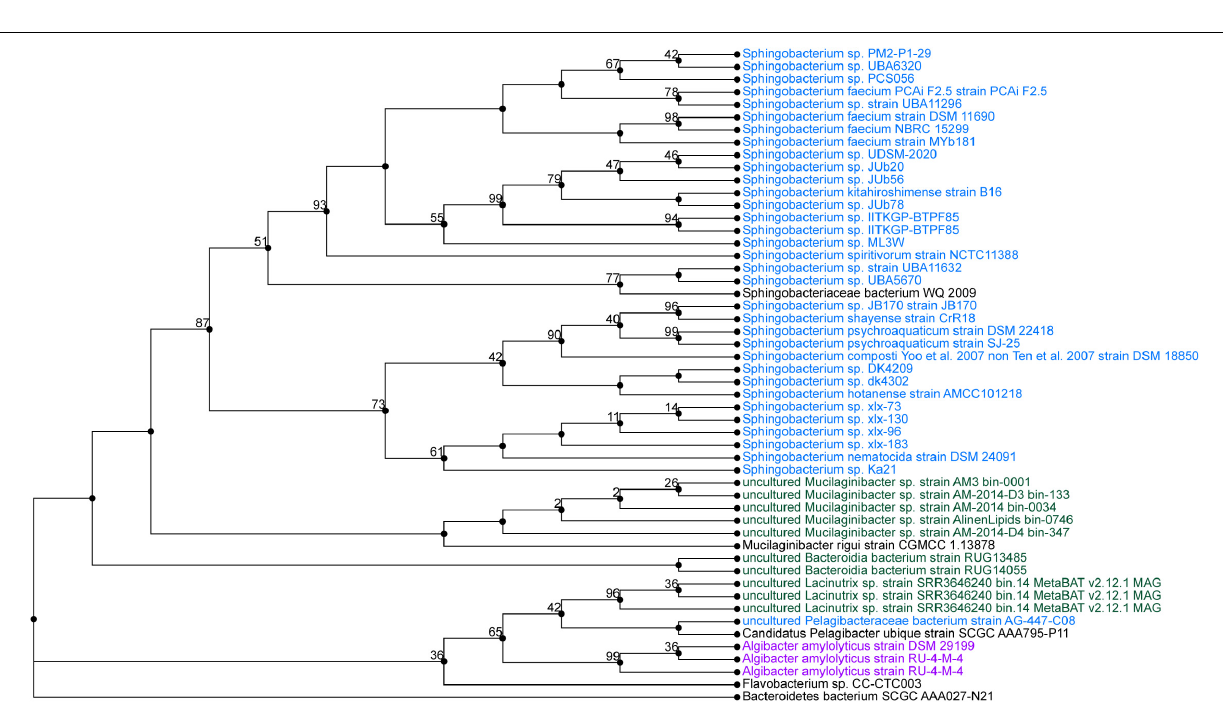
FIGURE 5 | Phylogenetic tree from maximum likelihood analysis of bacterial whole-genome sequence. The numbers in branch points denote confidence levels of the relationship of sequences determined by bootstrap statistical analysis. Sphingobacterium PCS056 was aligned with other representatives of the genus Sphingobacterium , with a confidence level of